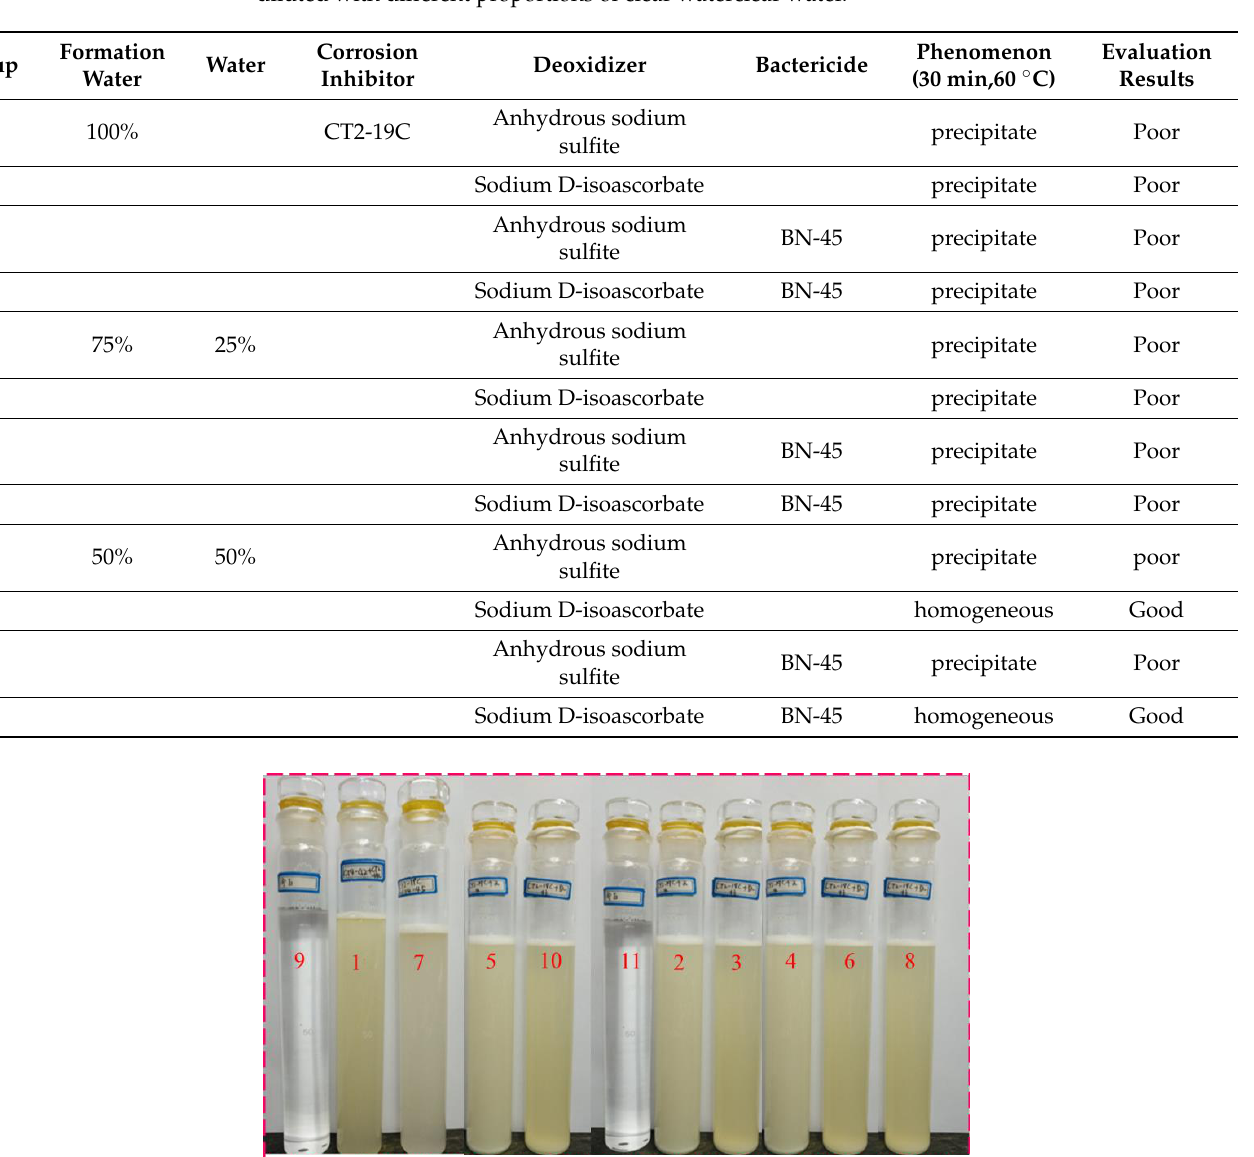
Table 8. Compatibility test scheme and results between various additives and formation water diluted with different proportions of clear waterclear water.